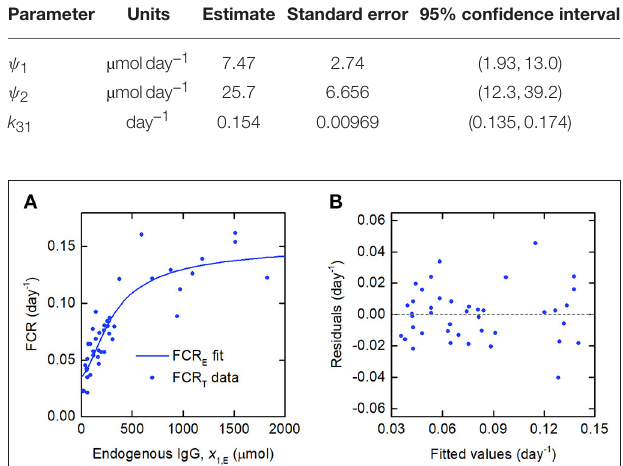
TABLE 4 | Coefficients of variation of parameter estimates obtained from 10 runs of differential evolution, for each of subjects A–F. Parameter